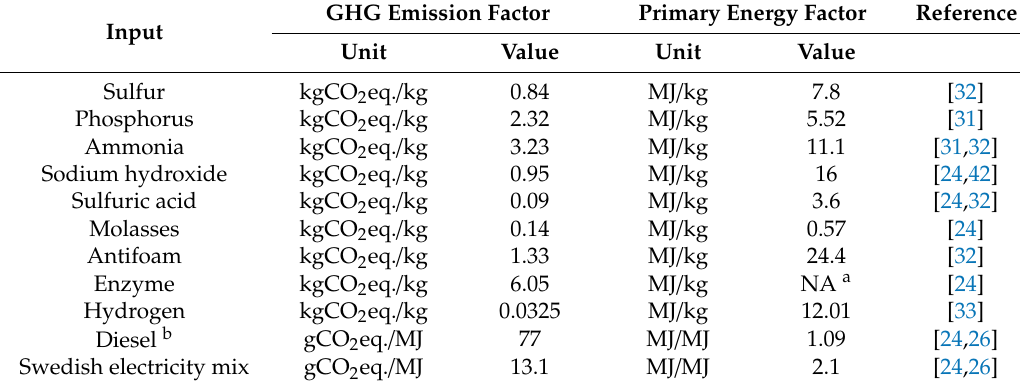
Table A4. GHG emission and primary energy factor of various inputs used in three pathways.